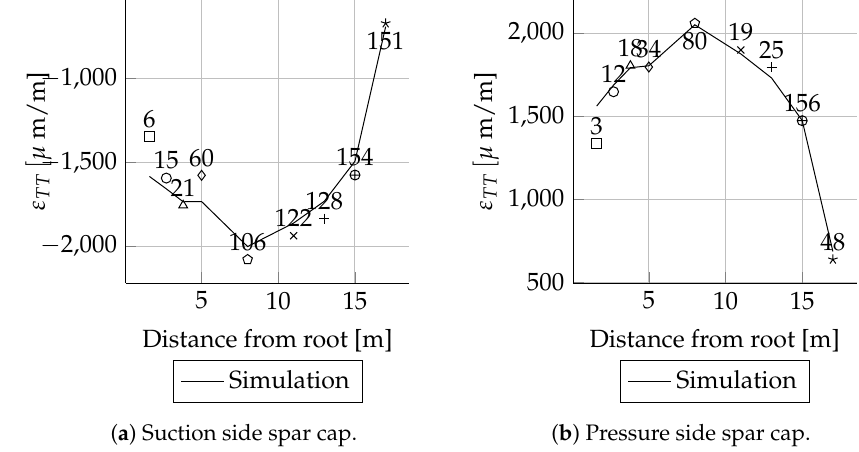
Figure A28. Strain comparison ε LL for Mymax load case.